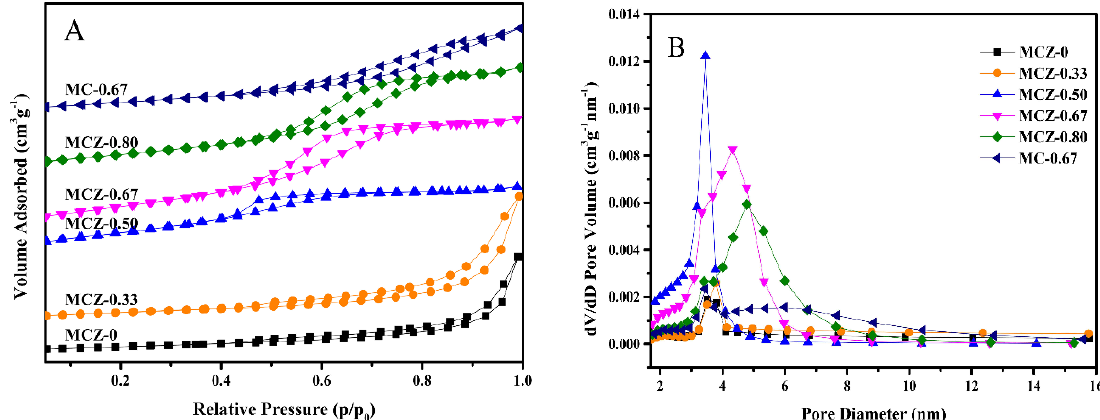
Figure 2. N 2 adsorption-desorption isotherms ( A ) and pore size distributions ( B ) of MCZ-x (x = 0, 0.33, 0.50, 0.67, 0.80) and MC-0.67 catalysts.